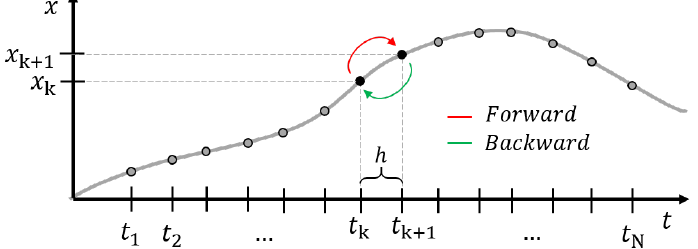
Figure A1. Graphical interpretation of the forward and backward linearization for a generic state-time evolution x